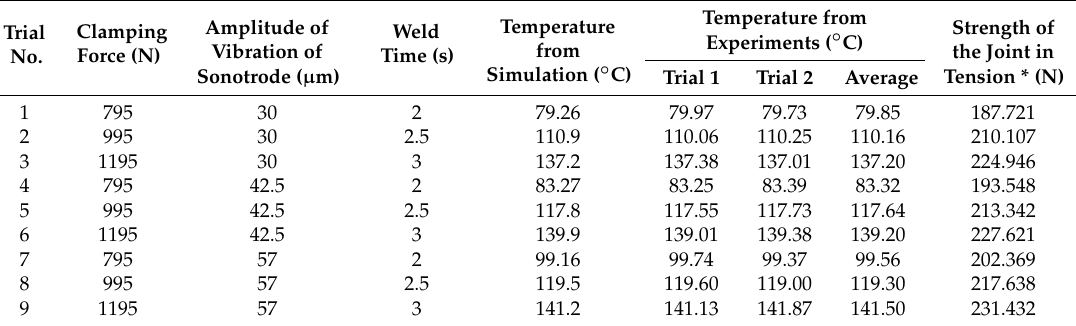
Table 3. Results of temperature from simulation and experiments.